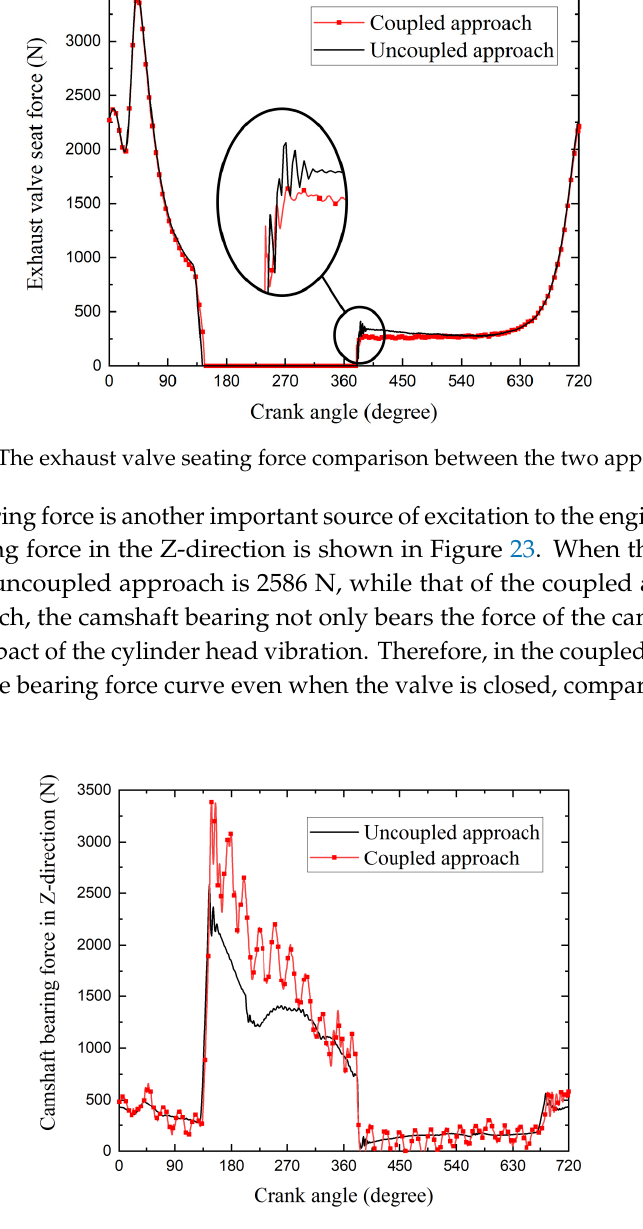
Figure 23. The camshaft bearing force in the Z-direction comparison between the two approaches.